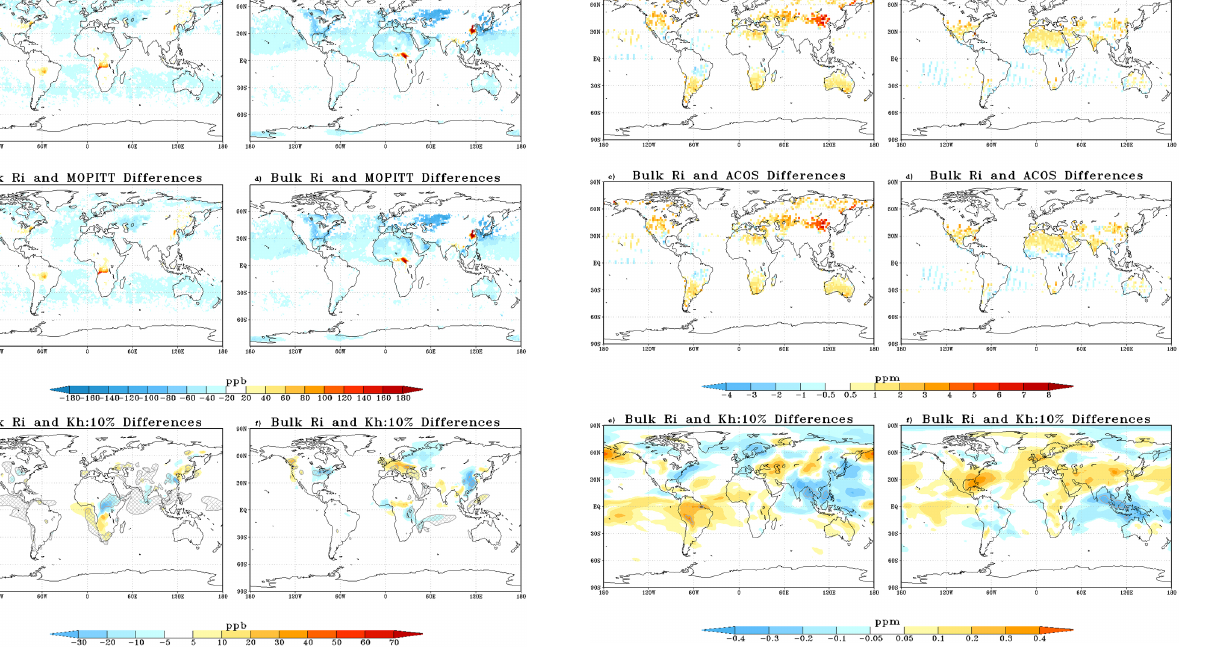
Figure 17. Seasonal mean surface CO differences. Method 2 minus MOPITT for JJA (a) and DJF (b) , Method 3 minus MOPITT for JJA (c) and DJF (d) , and Method 3 minus Method 2 for JJA (e) and DJF (f) . Model comparisons to MOPITT have been sampled using the MOPITT averaging kernel. Hatch marks on the bottom plots represent significance at the 90% level using the Student’s t test. Crosshatch marks represent significance at the 95% level.